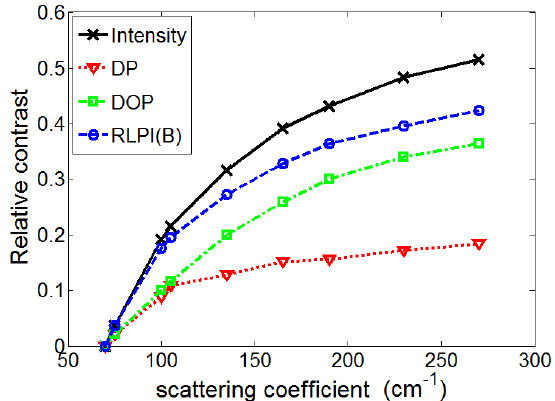
Fig. 4. Monte Carlo simulated relative contrasts of four ima- ging parameters: intensity, DP, DOP, RLPI parameter B, at di®erent scattering coe±cients for a monodisperse sphere scattering model. The diameter and refractive index of spherical scatterer are 7 (cid:5) m and 1.4, respectively. The scattering coe±- cient varies from 70 cm (cid:1) 1 to 270 cm (cid:1) 1 to simulate the cancer- induced cell proliferation.